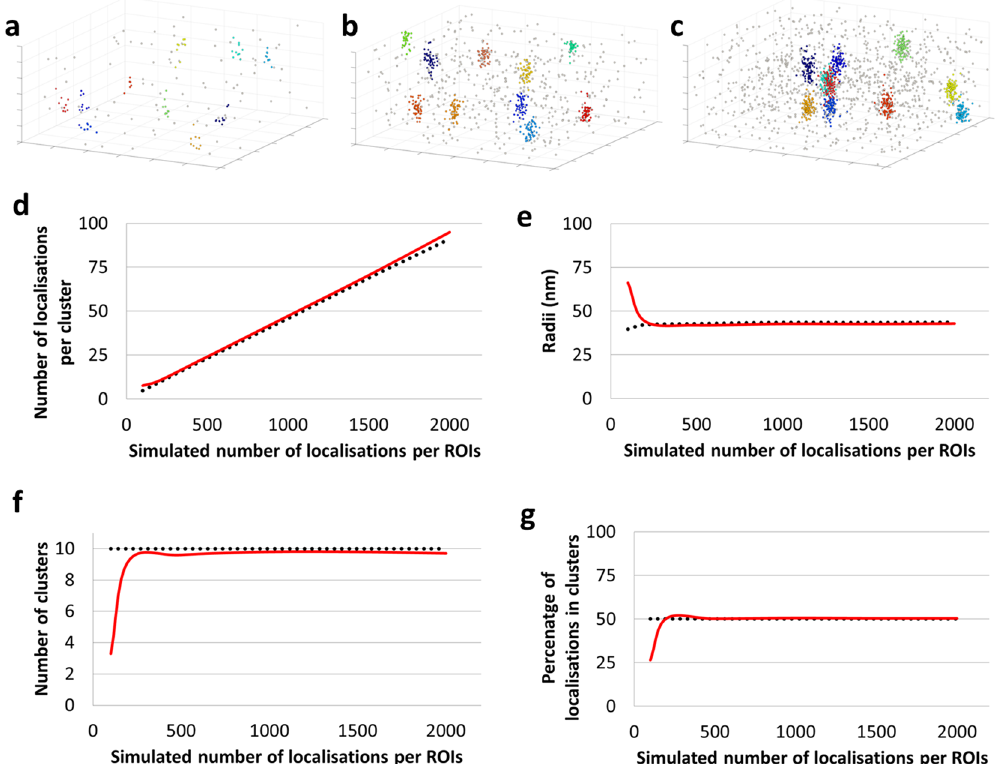
Figure 2. Examining the effect of increasing total number of localisations in the ROI on the Bayesian cluster analysis of simulated data sets (n = 30 simulations) from 100 localisations per ROIs to 2000 localisations per ROIs, under the Standard Conditions. Representative cluster maps with ( a ) 200, ( b ) 1000 and ( c ) 2000 localisations within the 3000 × 3000 × 600 nm ROI. ( d ) Mean number of detected localisations per cluster as a function of the number of localisations per cluster, compared to the simulated (true) value, ( e ) mean cluster radii as a function of the number of localisations per cluster, compared to the simulated (true) value, ( f ) mean number of detected clusters per ROI as a function of the number of localisations per cluster, compared to the simulated value and ( g ) mean percentage of localisations detected in clusters as a function of the number of localisations per cluster, compared to the simulated value. Red = results of the analysis, black = simulated